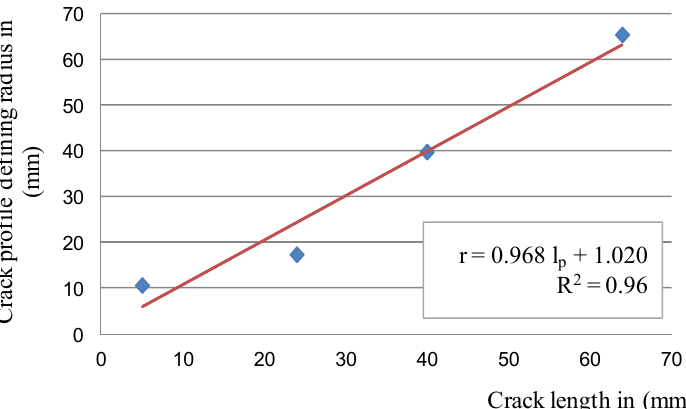
Figure 14. The relationship between the radius of the arc defining the crack depth and its length; blue—radius values for individual cracks determined from the regression functions of circles, red— linear regression for these values.